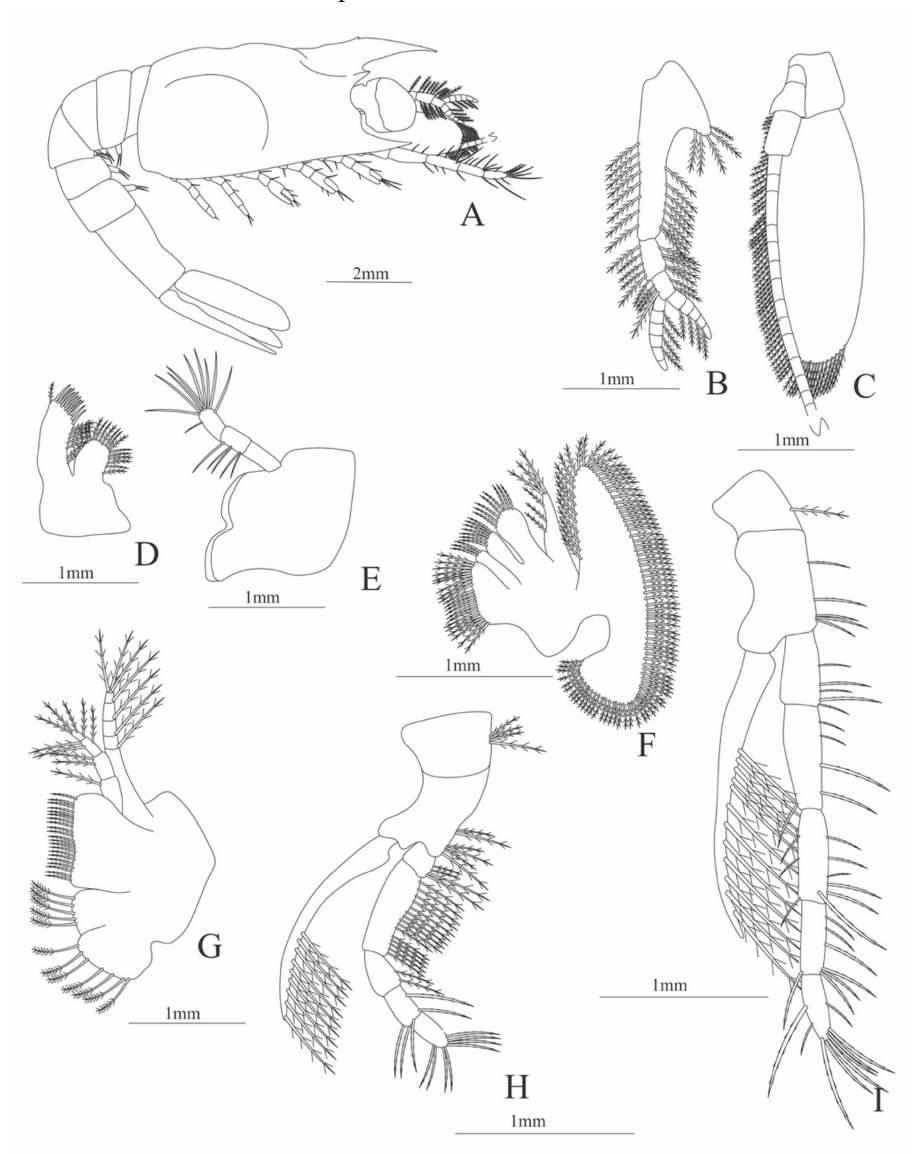
Figure 25. Hemipenaeus carpenteri : ( A ) lateral view; ( B ) antennule; ( C ) antenna; ( D ) maxillule; ( E ) mandible; ( F ) maxilla; ( G ) first maxilliped; ( H ) second maxilliped; ( I ) third